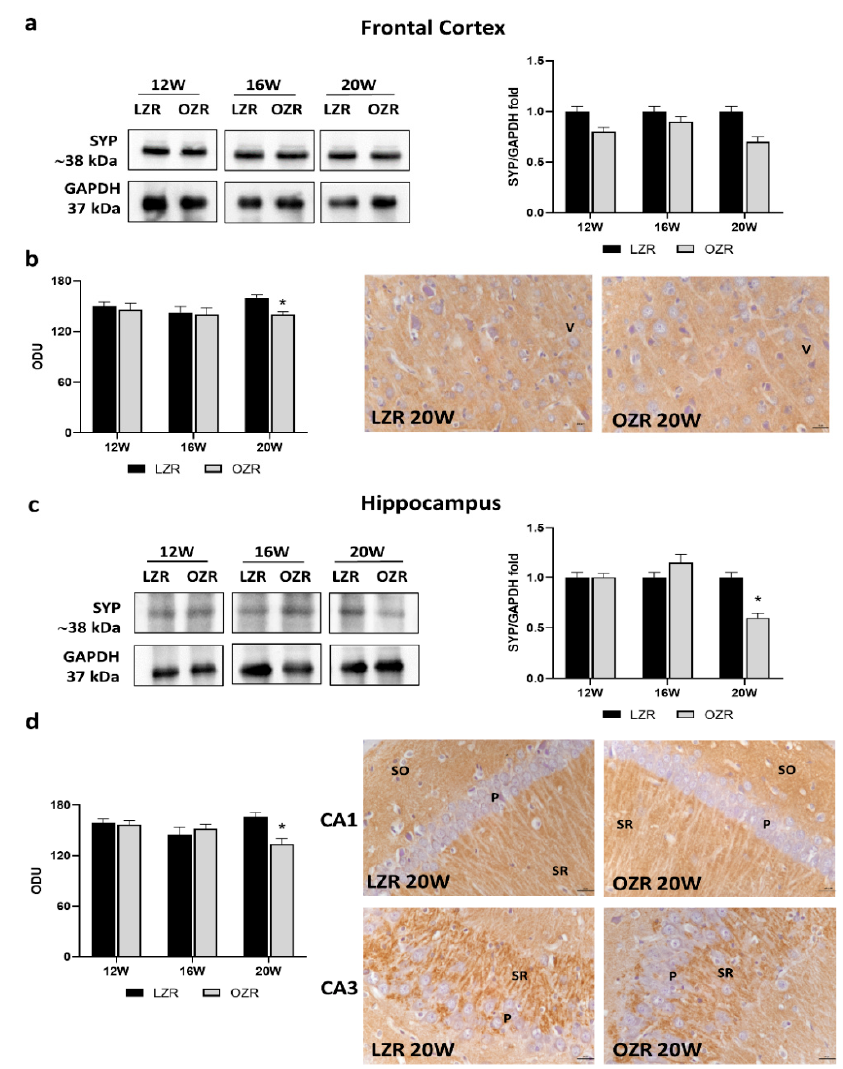
Figure 5. Immunoblotting and immunoreaction of synaptophysin (SYP). Lysates of the frontal cortex ( a ) and hippocampus ( c ) from lean Zucker rats (LZRs) and obese Zucker rats (OZRs) at the age of 12, 16, and 20 weeks were immunoblotted using specific anti-SYP. Bar graphs indicate the densitometric analysis using LZRs as control, and GAPDH levels were used as the loading control. Blots are representative of one of three separate experiments; intensity values of SYP immunostaining in the frontal cortex ( b ) and hippocampus ( d ) from LZRs and OZRs at the age of 12, 16, and 20 weeks measured in optical density units (ODUs). Data are mean ± S.E.M. * p < 0.05 vs. age-matched LZRs. Representative pictures of 20-week-old LZRs and OZRs in frontal cortex ( b ) and hippocampus ( d ). V: the fifth layer of the frontal cortex. P: pyramidal neurons in the CA1 and CA3 subfields of the hippocampus. SO: stratum oriens . SR: stratum radiatum . 40 × magnification. Calibration bar: 25 µ